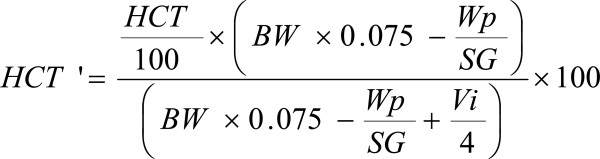
Formula for predictive HCT after phlebotomy. HCT: hematocrit, HCT': predictive HCT after phlebotomy, BW: body weight, Wp: weight of phlebotomy, SG: specific gravity, Vi: volume of infusion.